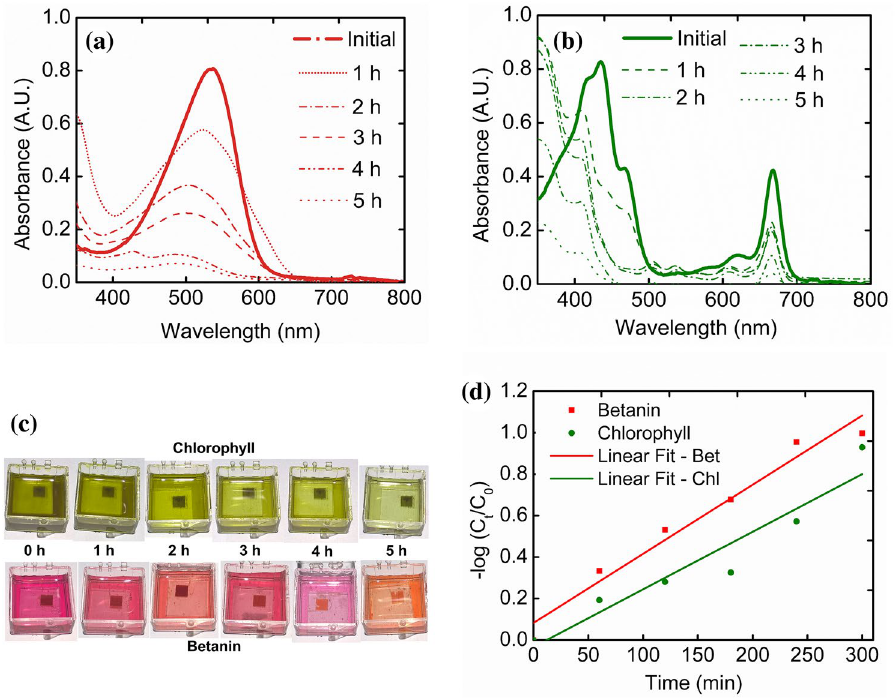
Fig. 6 Photocatalytic activity of TiO 2 resulting in a decrease in the intensity of absorbance by a betanin, b chlorophyll. c The degradation of dye color on the photoanodes over 5 h. d Pho- tocatalytic degradation follows first order